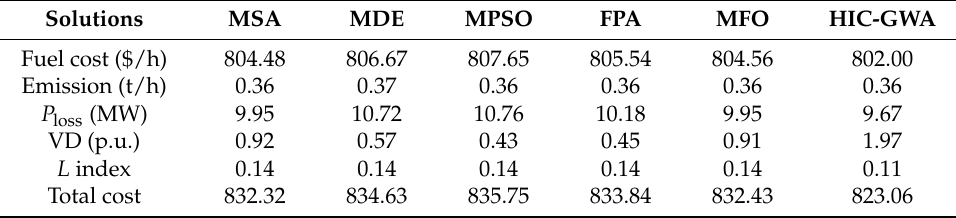
Table 14. Comparison of the proposed approach with different approaches for case